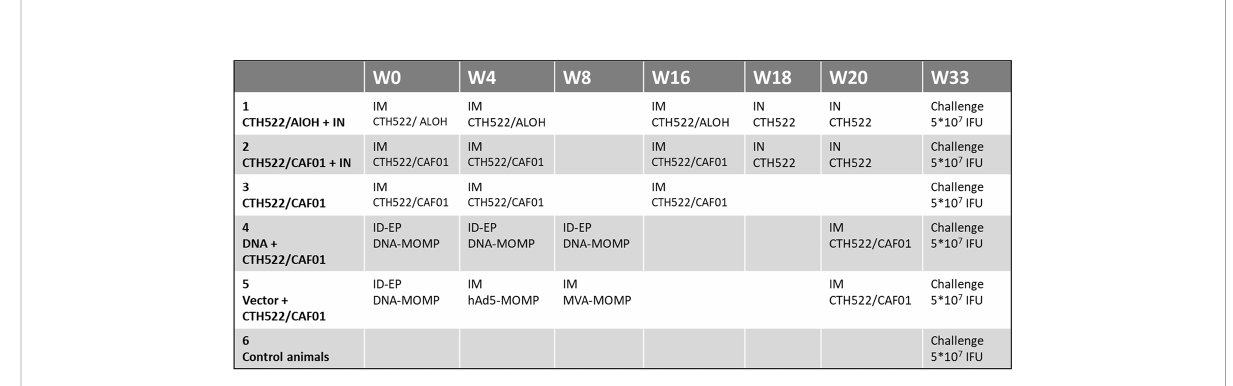
FIGURE 1 Study design. The fi gure shows the groups, the vaccines and the administration routes (intramuscular, IM, or intranasal, IN)